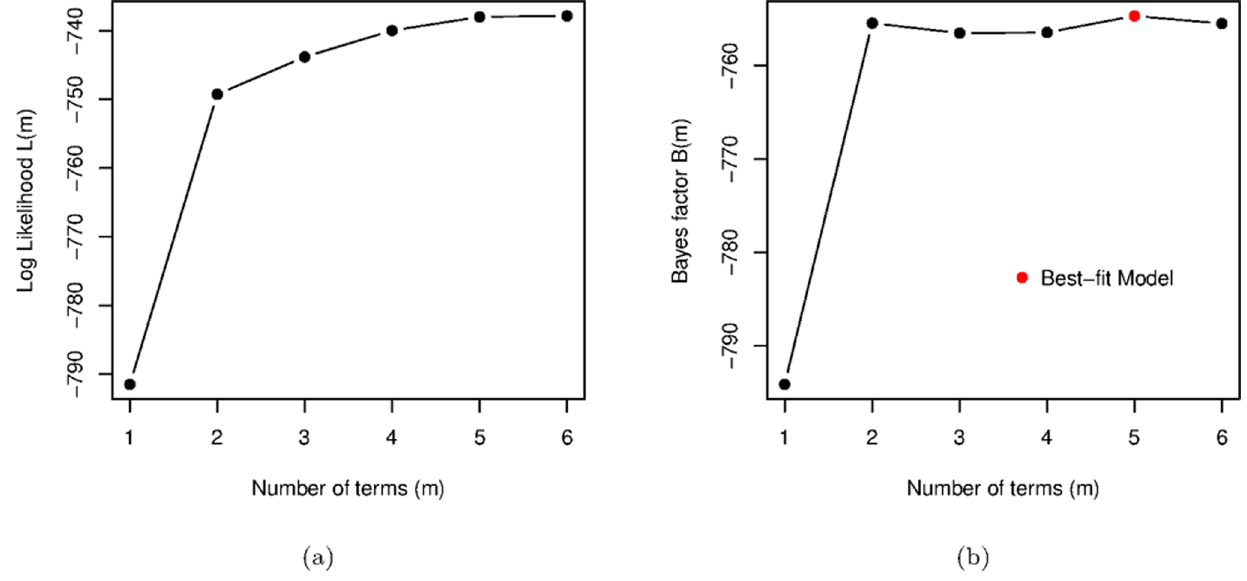
Figure 2. Change in Democracy models. (a) The Log Likelihoods and (b) Bayes Factors for the same models.